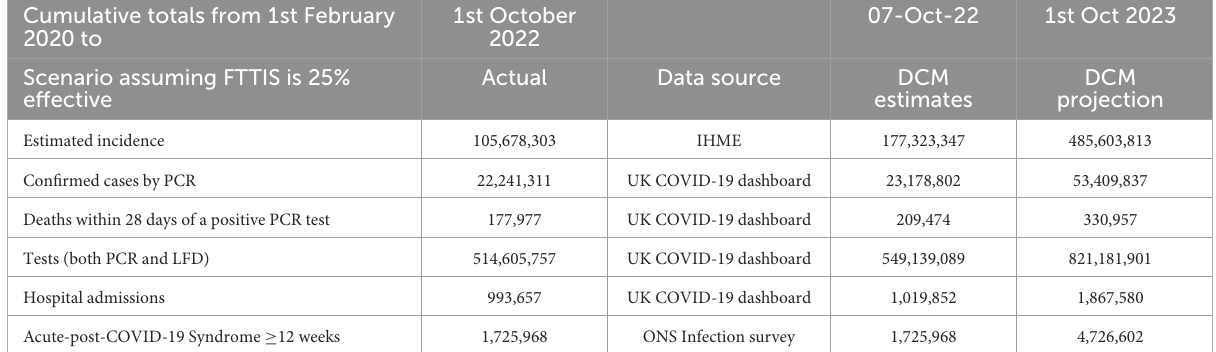
TABLE 1 The cumulative effect of COVID-19 to October 2023 projected by the DCM on 1 st October 2022 for